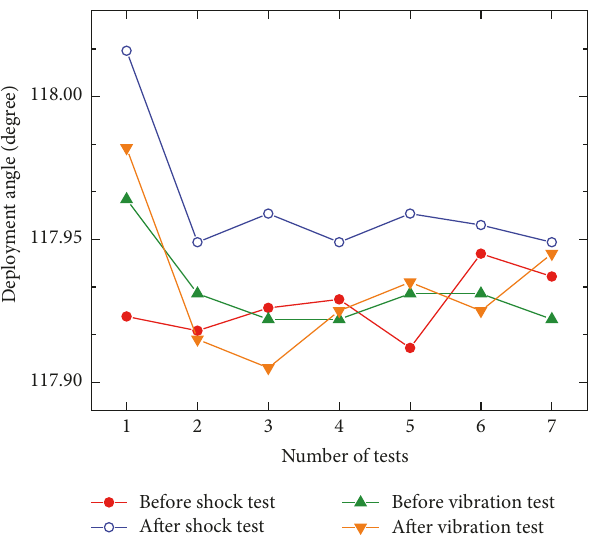
Figure 13: Measured deploying angle values before and after launch environment